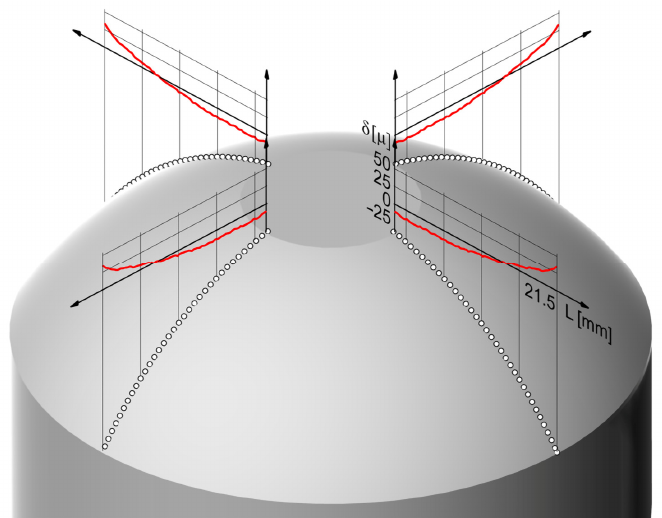
Figure 22. Distributions of shape deviation δ recorded in the studies with an adaptive control mechanism ( δ max = 0.033 mm, S = 0.012 mm).